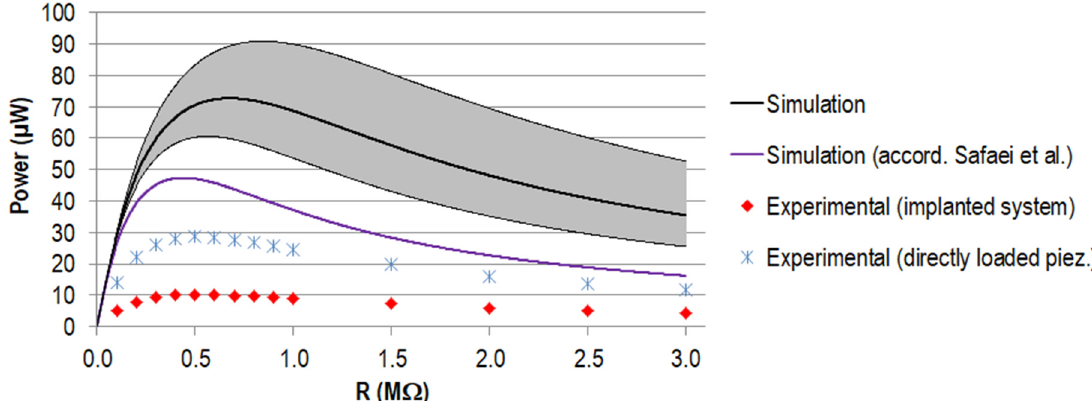
Figure 10. Generated power P (µW) for different load resistances R for the stacked configuration. Simulation data for the capacity provided by the manufacturer (in black, with a tolerance of ±20% in grey) and the capacity calculated according to Safaei et al. [56,57] (in purple). Experimental data are displayed for the implanted system (in red) and the directly loaded piezoelectric element in blue.